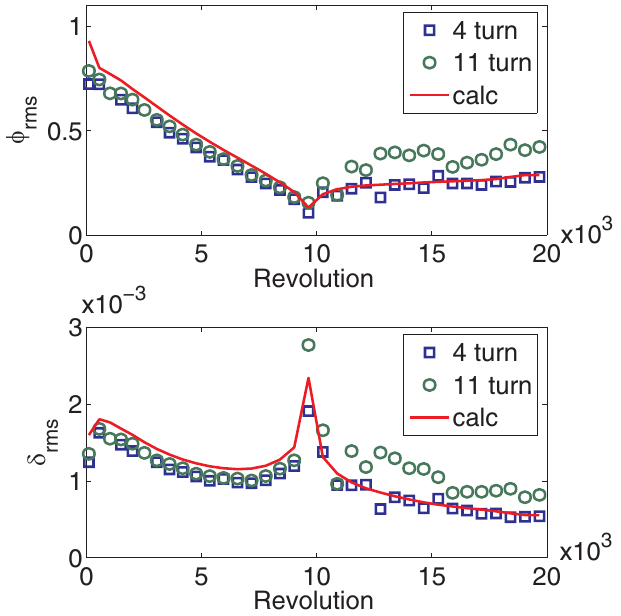
FIG. 19. (Color) The measured rms bunch length (cid:2) (top) and (cid:10) (bottom) for 4-turn and 11-turn rms momentum width (cid:2) (cid:5) injection are compared to those calculated with phase-space area 0 : 08 eV - s . The measurements were taken on 29 April 2005 under event